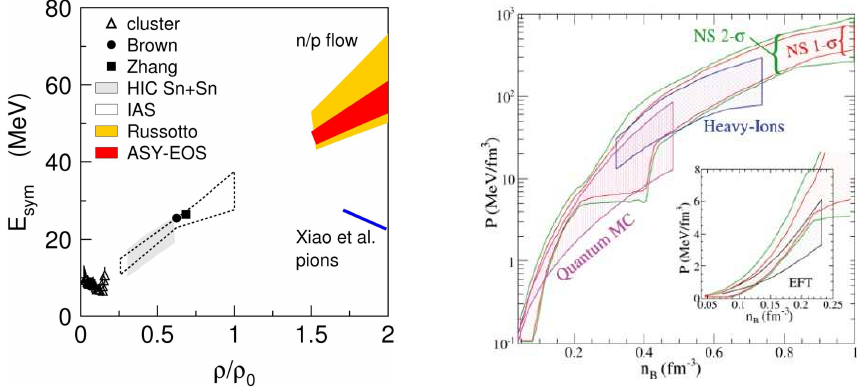
Figure 9. (left panel) Constraints deduced for the density dependence of the symmetry energy from Figure 9. ( Left panel ) Constraints deduced for the density dependence of the zero-temperature the ASY-EOS data in comparison with the FOPI-LAND result of Ref. [31] as a function of the reduced symmetry energy from the ASY-EOS data (red area, [37]) in comparison with the FOPI-LAND density ρ / ρ 0 . The low-density results of Refs. [24,47–49] as reported in Ref. [3] are given by the symbols, the gray area (HIC), and the dashed contour (IAS); see also text. Figure taken from Ref. [30]. result (yellow area, [38]) as a function of the reduced density ρ / ρ 0 . The low-density results (right panel) Synopsis of constraints on the EoS of neutron star, β -stable matter from microscopic of [30,58–60] as reported in [3] are given by the symbols, the gray area (heavy-ion collision—HIC), calculations (Quantum Monte-Carlo and effective field theory (EFT)), heavy ion collisions and neutron and the dashed contour (isobaric analog resonances—IAS); see also text. Figure taken from [37]. star (NS) observations in a pressure-density diagram. Figure taken from A.Steiner et al. [5]. ( Right panel ) Synopsis of constraints on the equation of state (EoS) of neutron star (NS) β -stable matter from microscopic calculations (quantum Monte Carlo and effective field theory (EFT)), heavy-ion collisions, and NS observations in a pressure–density diagram. Figure taken from A. Steiner et al. [6] with